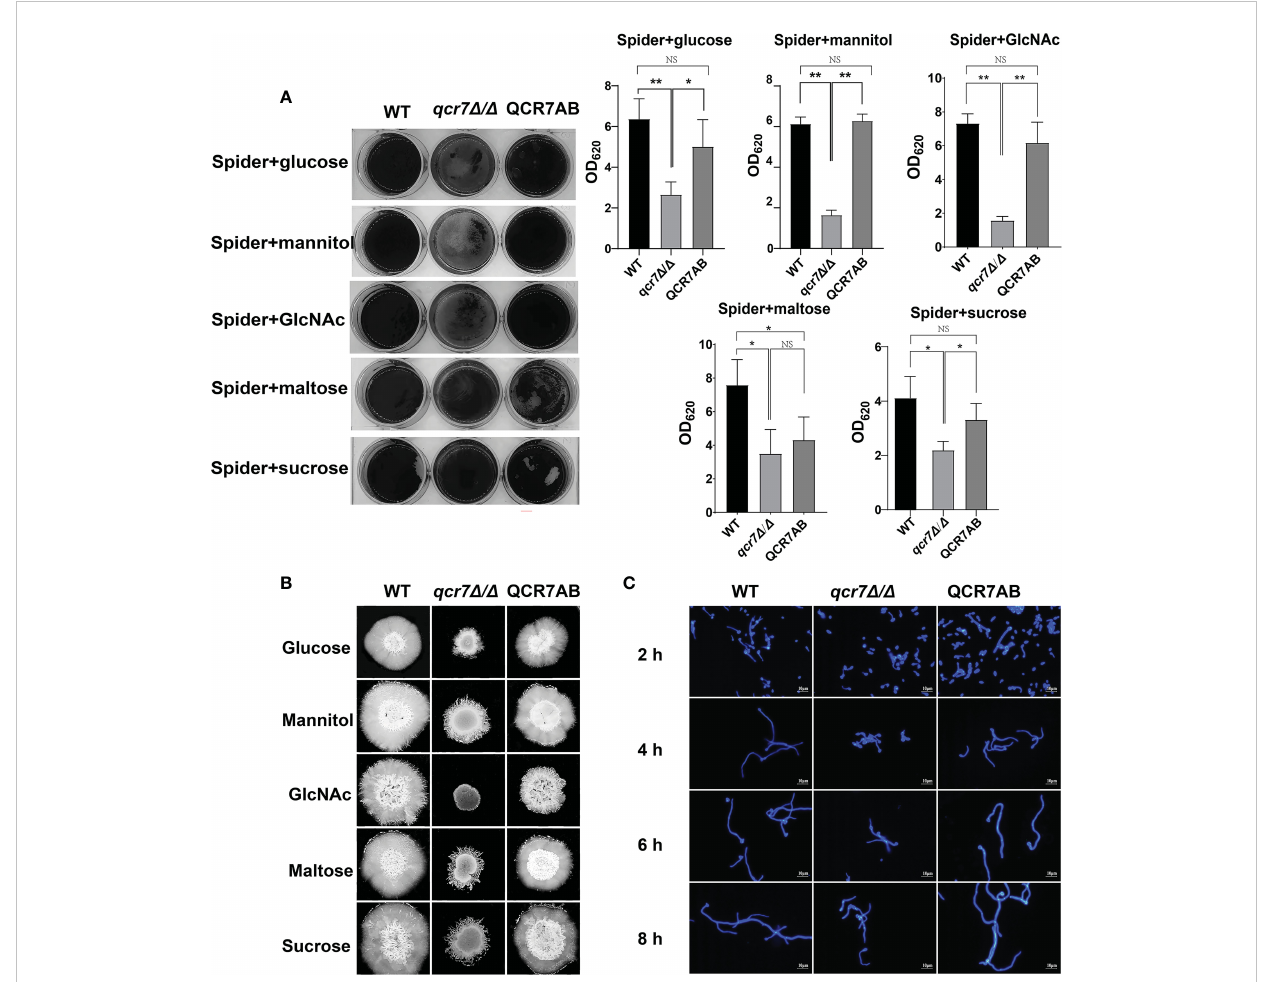
FIGURE 4 Deletion of QCR7 affects bio fi lm formation and hyphal growth maintenance in Candida albicans under various carbon sources, with the most signi fi cant effect under GlcNAc conditions. (A) C albicans suspensions of 5 × 10 6 cells in Spider medium supplemented with mannitol, glucose, sucrose, maltose, and GlcNAc as sole carbon sources were incubated in 12-well fl at-bottom plates at 37°C for 90 min, after which nonattached cells were removed from the wells by washing once with PBS. Fresh corresponding induction medium was added to each well and incubated at 37°C for 48h. Next, each well was washed with PBS and stained with crystal violet; after decolorization, measurements were taken using a microplate reader at 620 nm. “ * ” represents p < 0.05 and “ ** ” represents p < 0.01 for the WT vs. mutant strains. (B) Each cell type (1 × 10 5 cells in 5 µl of PBS) was spotted on the Spider medium, containing 2% glucose, 2% mannitol, 2% maltose, 2% sucrose, and 2% GlcNAc at 37°C. Photographs were then taken after 7 days of growth. (C) The wild type, qcr7 D / D , and QCR7AB were cultured overnight in liquid YPD at 30°C, followed by washing and dilution to OD 600 nm = 0.1 of PBS, after